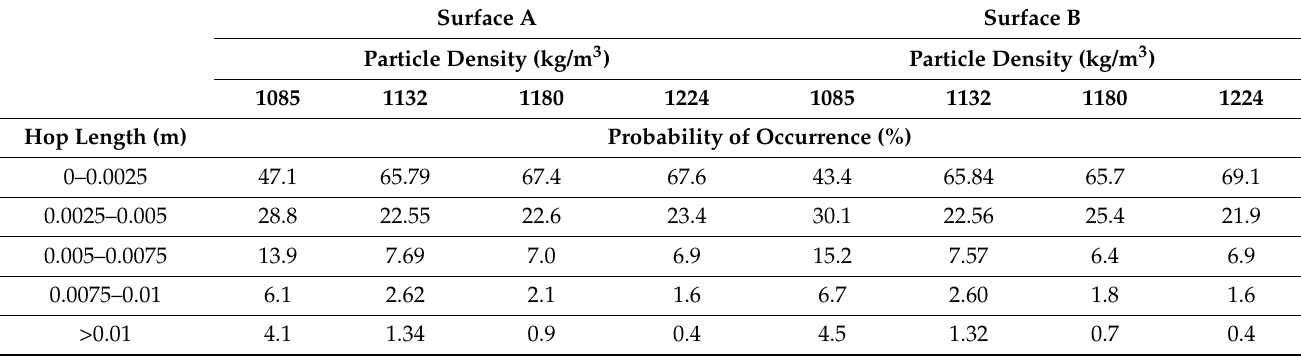
Table A1. The effect of different particle densities on the hop distance Gamma distribution model parameters, for bed surface A (and Reynolds number of 50,789), and bed surface B (and Reynolds number of 51,488). These tabulated data correspond to the results plotted in Figure 11b,d.